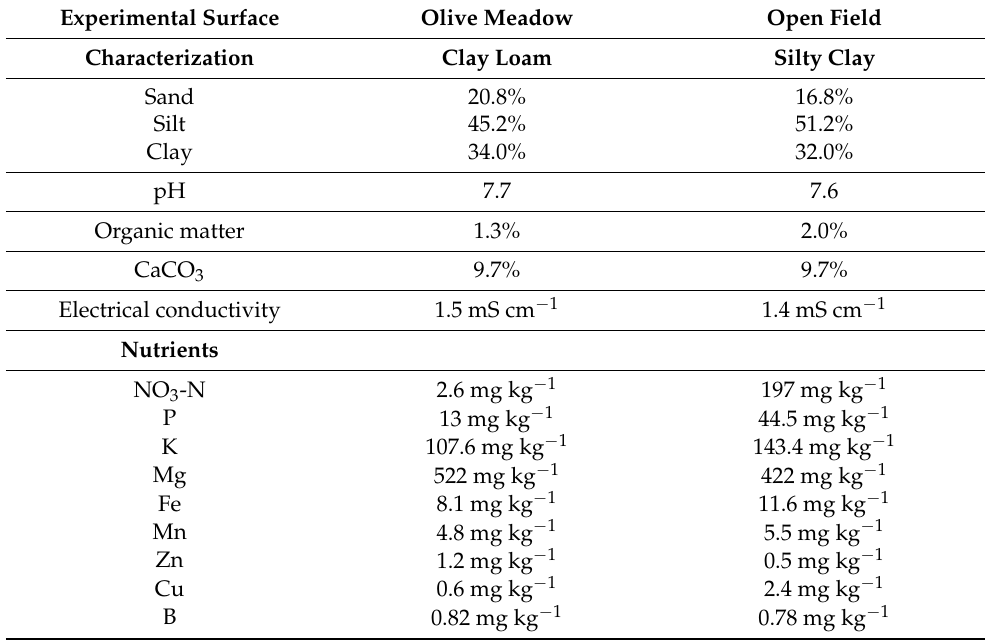
Table 1. Soil characteristics of the experimental